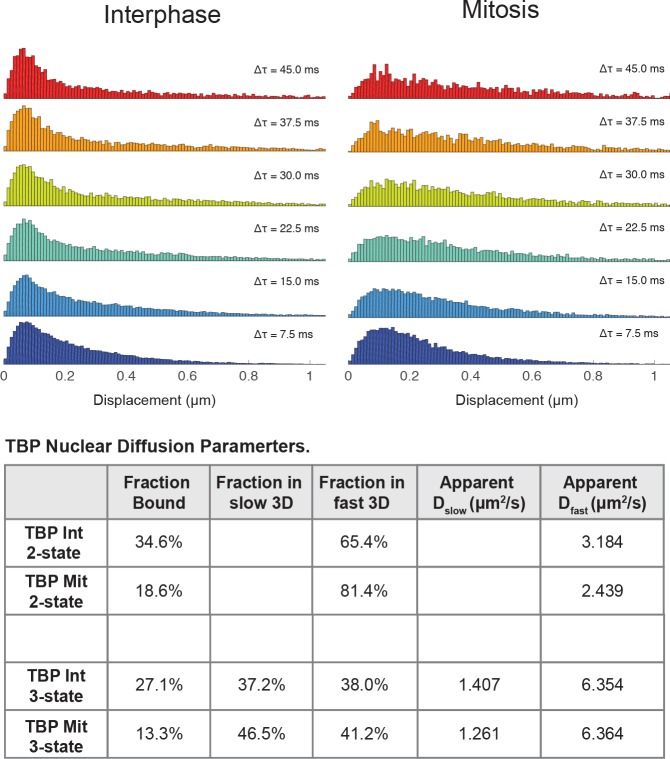
Halo-TBP shows increased movement in mitosis relative to interphase.The jump lengths distribution is displayed for consecutive time frames, from Δτ = 7.5 ms to Δτ = 45.0 ms for interphase (left) and mitotic (right) cells. A summary table showing the observed fits for each parameter in a 2-state vs 3-state kinetic model is also presented.